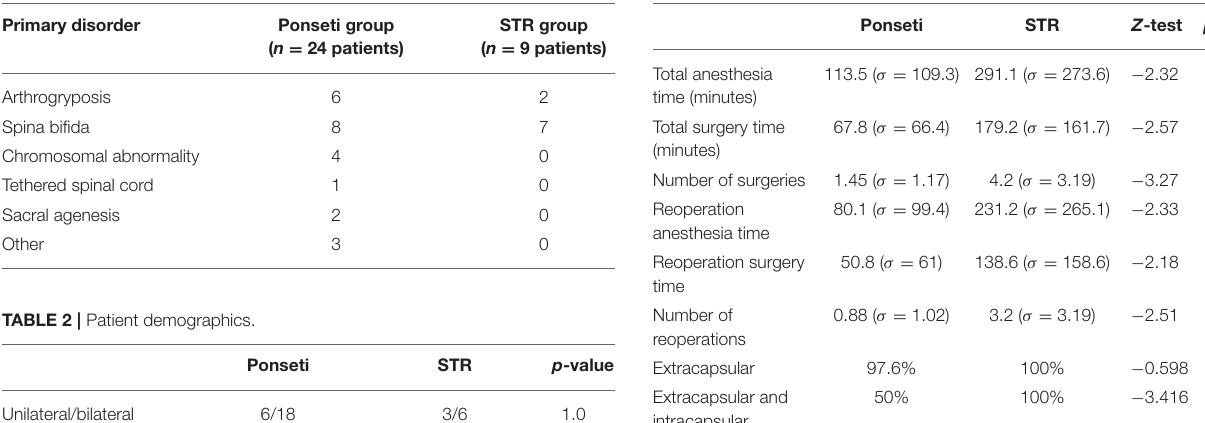
TABLE 4 | Descriptive